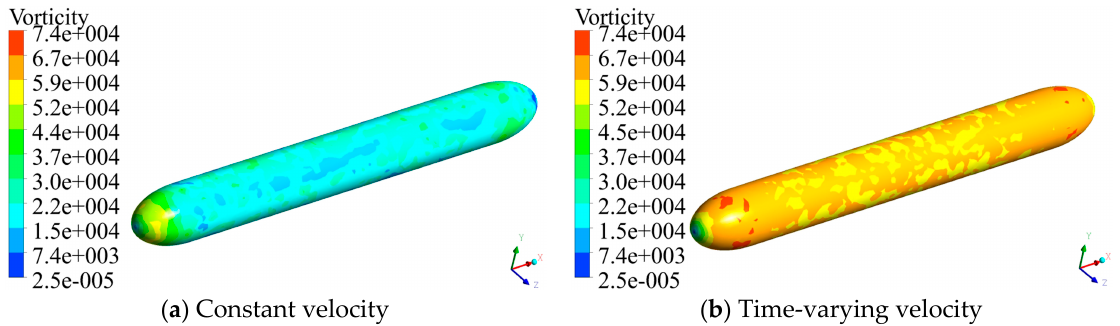
Figure 12. Vorticity of the axisymmetric body under different incoming flow conditions.